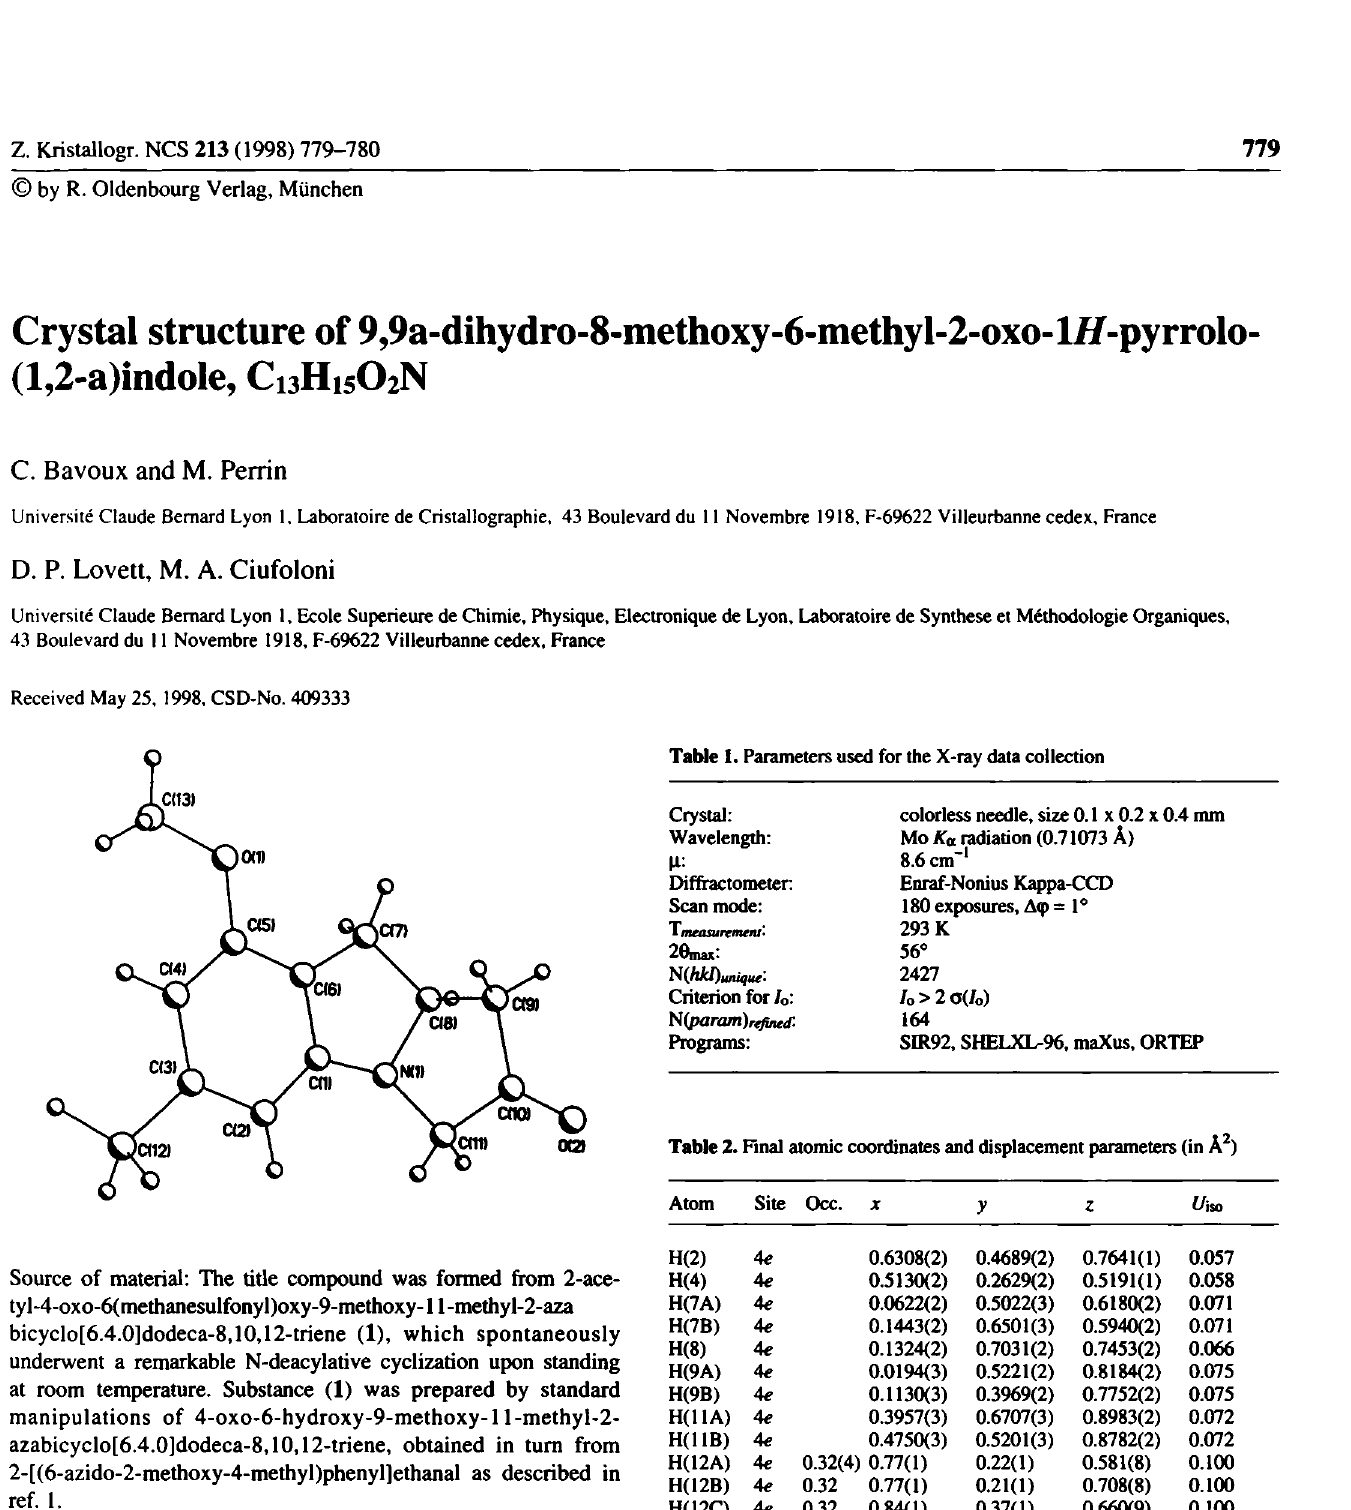
Table 2. Final atomic coordinates and displacement parameters (in